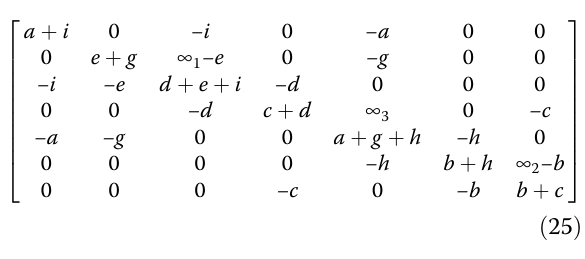
Results of Tow-Thomas band-stop filter circuit and Akerberg-Mossberg band-stop filter circuit